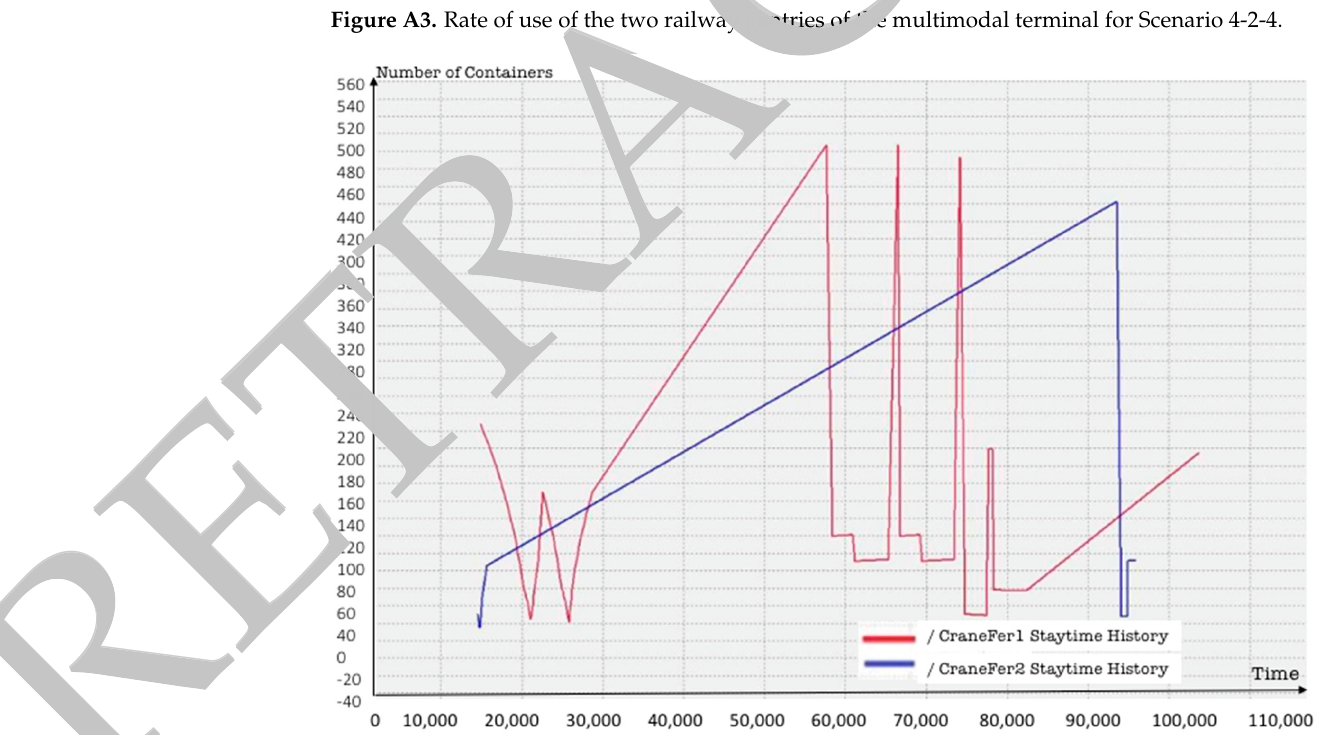
Figure A4. Utilization rate of the two railway gantries of the multimodal terminal for Scenario 5-2-